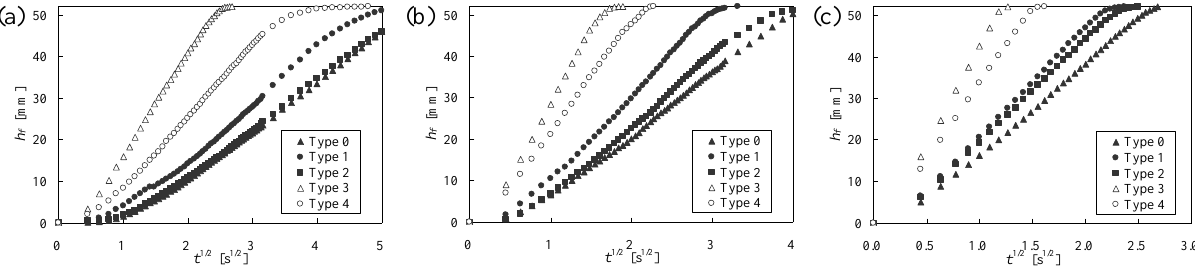
Fig. 6 Advancement of air-liquid interface h versus square root of time t in cases of (a) H =100 mm, (b) H =200 mm, and f (c) H =300 mm. Except for the very initial and final states, the plots are almost